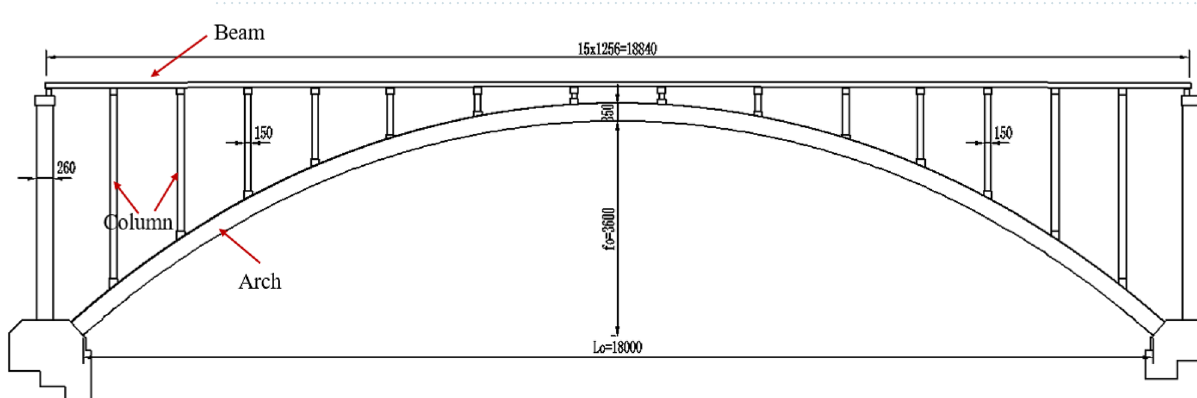
Figure 2. The calculation process of the initial buckle cable force.